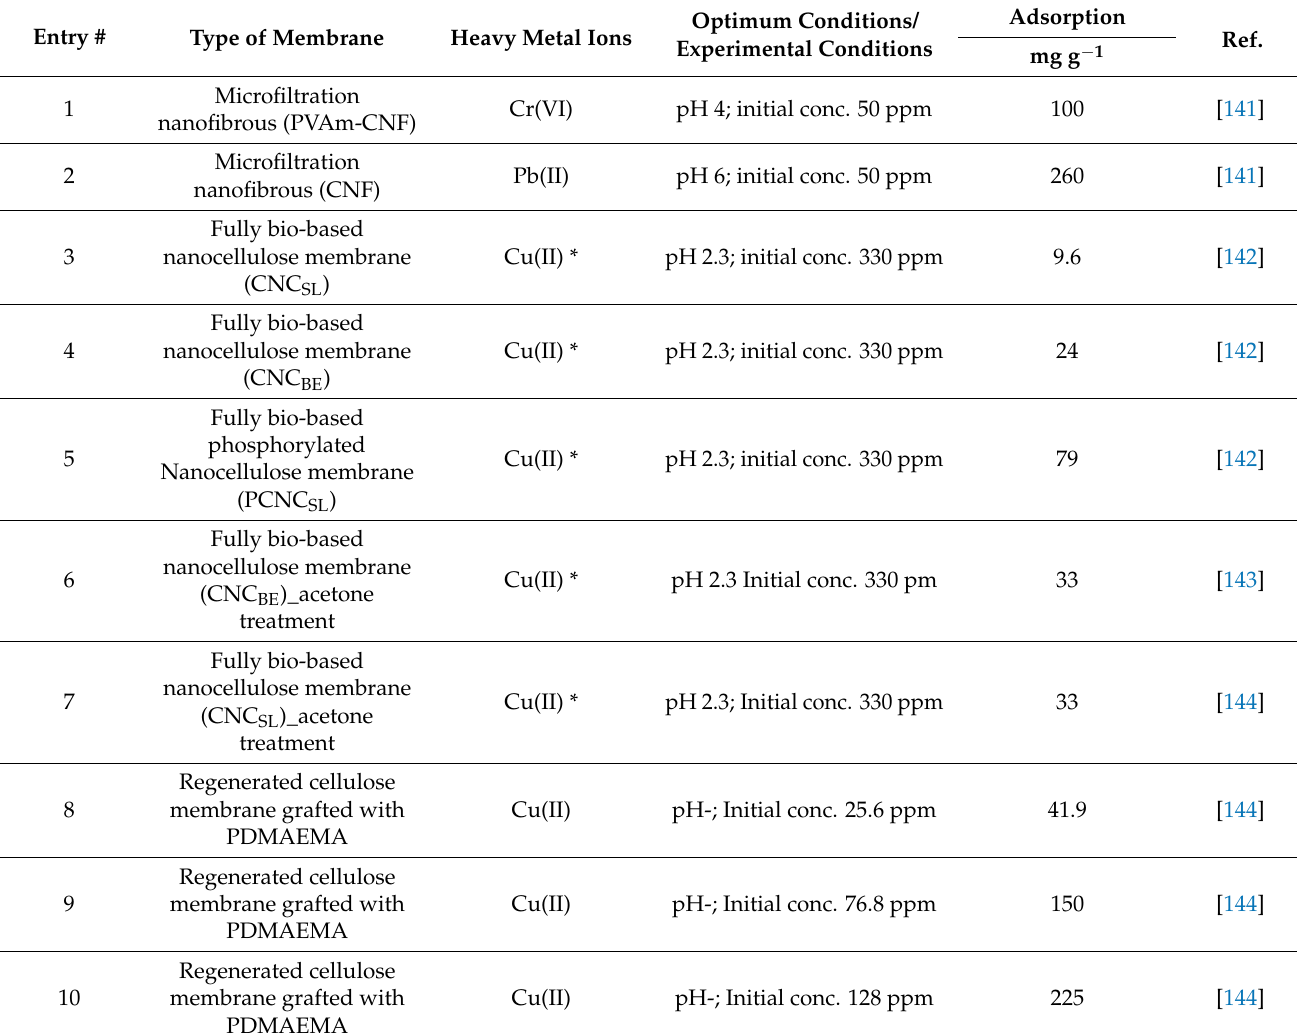
Table 5. Performance of recent cellulose-based adsorptive